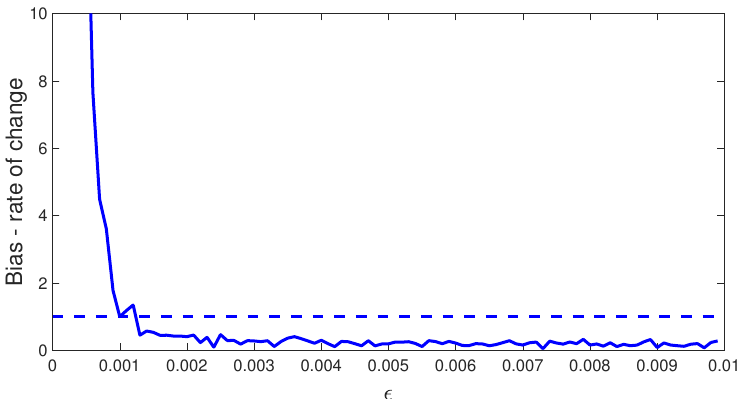
Figure 6. The rate of change in the rounding bias 1 ∆ ( e Y , (cid:101) + ∆ − e Y , (cid:101) ) plotted against the rounding threshold (cid:101)